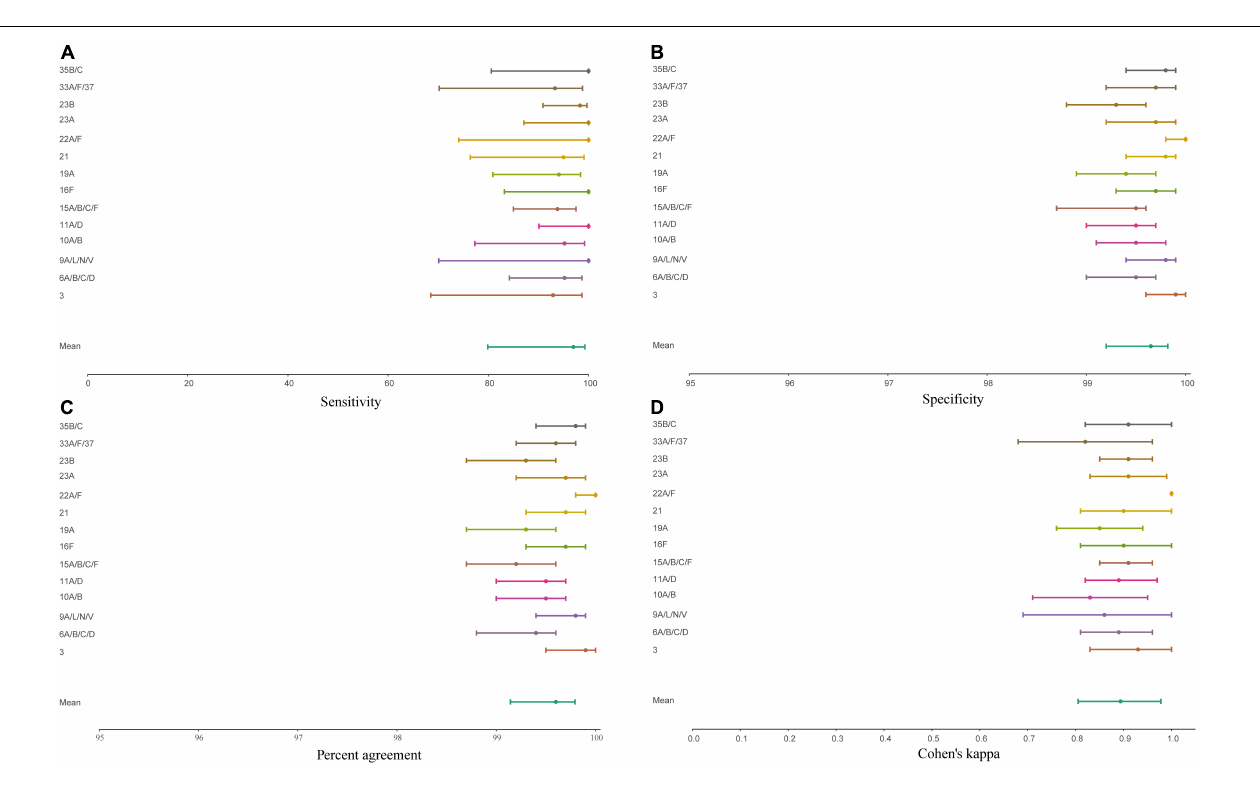
FIGURE 5 | Forest plot displaying the point estimate and 95% confidence of intervals sensitivity (A) , specificity (B) , concordance (C) , and Cohen’s kappa (D) for molecular diagnostic tests applied to culture-enriched samples when compared to isolation of S. pneumoniae strains of particular serotype/serogroup